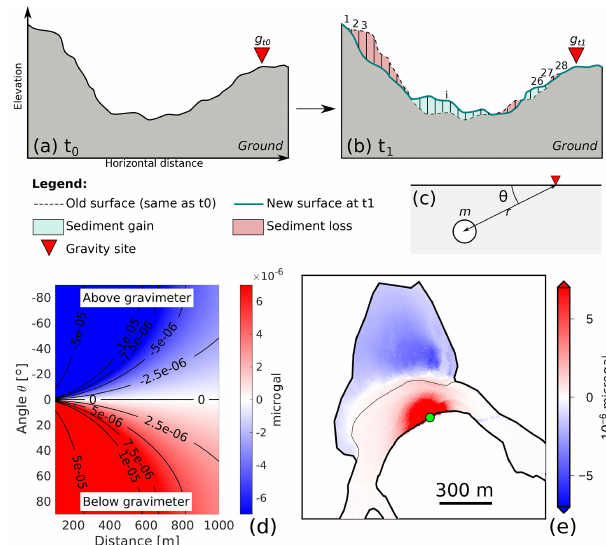
Figure 2. (a) Ground surface elevation at time t 0 when gravity is measured and equal to g t 0 . (b) New ground surface at t 1 > t 0 af- ter sediment mass redistributions occurred. This mass redistribu- tion is discretized in 28 prisms for the gravity modeling (Eq. 1). The gravity is measured again at the same place and is equal to g t 1 . (c) Parameters used for computing a point-mass gravity effect (Eq. 1; point mass means that the element is approximated to a point where the mass is that of the element). (d) Theoretical effect of a 2000kg point mass as a function of its distance and angle (Eq. 1) from the gravimeter. (e) Synthetic gravity effect at one measure- ment site (green dot; actually BA04) for each mass element located at the surface of the Paolai riverbed or landslide. A mass element is a 0.5m × 0.5m × 1m rectangular prism of density 2, whose height is given by the actual topography of the area (Fig. 1). The actual gravity effect measured at the green site is the sum of each element of the gravity effect. The color scale is saturated to highlight the change in sign across the landslide